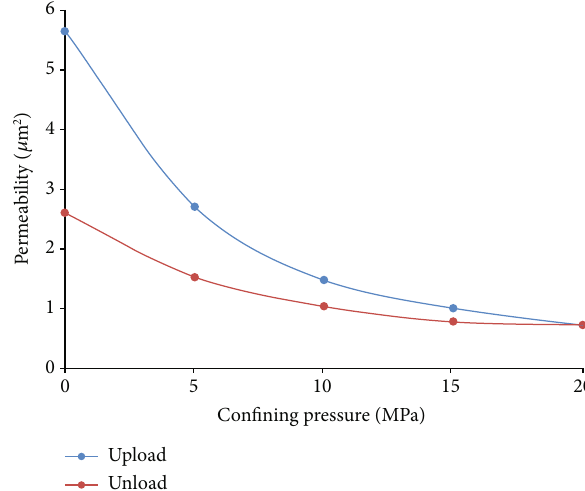
Figure 5: The permeability versus con fi ning pressure for fractured- porous